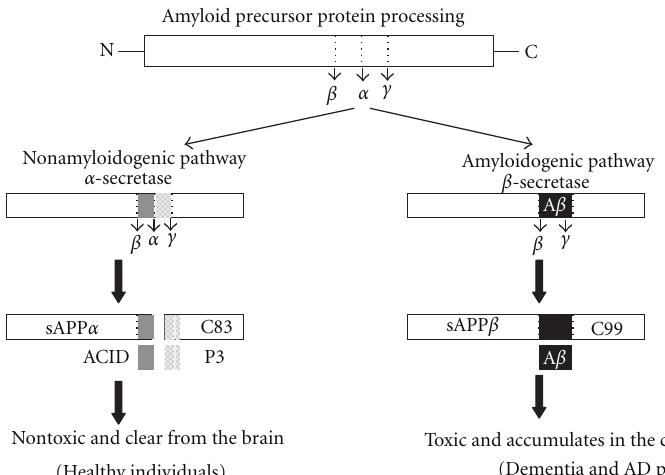
Figure 2: APP processing in nondemented healthy individuals and AD patients. APP processing occurs by two pathways: a beta- secretase-based amyloidogenic and alpha-secretase-based nonamyloidogenic pathway. In the nonamyloidogenic pathway (left), cleavage occurs by alpha-secretase within the amyloid-beta domain and generates the large soluble N-terminal fragment (sAPP α ) and a non- amyloidogenic C-terminal fragment of 83 amino acid residues (C83). Further cleavage of this C-terminal fragment by γ -secretase generates the nonamyloidogenic peptide (P3) and APP intracellular domain (ACID). These products are nontoxic. The non-amyloidogenic α -secretase pathway occurs in over 90% of humans, and these individuals generally do not develop dementia. In the amyloidogenic pathway (right), cleavage occurs by β - secretase at the beginning of the amyloid-beta domain and generates a soluble N-terminus fragment (sAPP β ) and amyloidogenic C-terminal fragment of 99 residues (C99). This C-terminal fragment is further cleaved by γ -secretase and generates amyloid- beta. The amyloidogenic pathway occurs in approximately 10% of total humans, and these individuals might develop dementia and